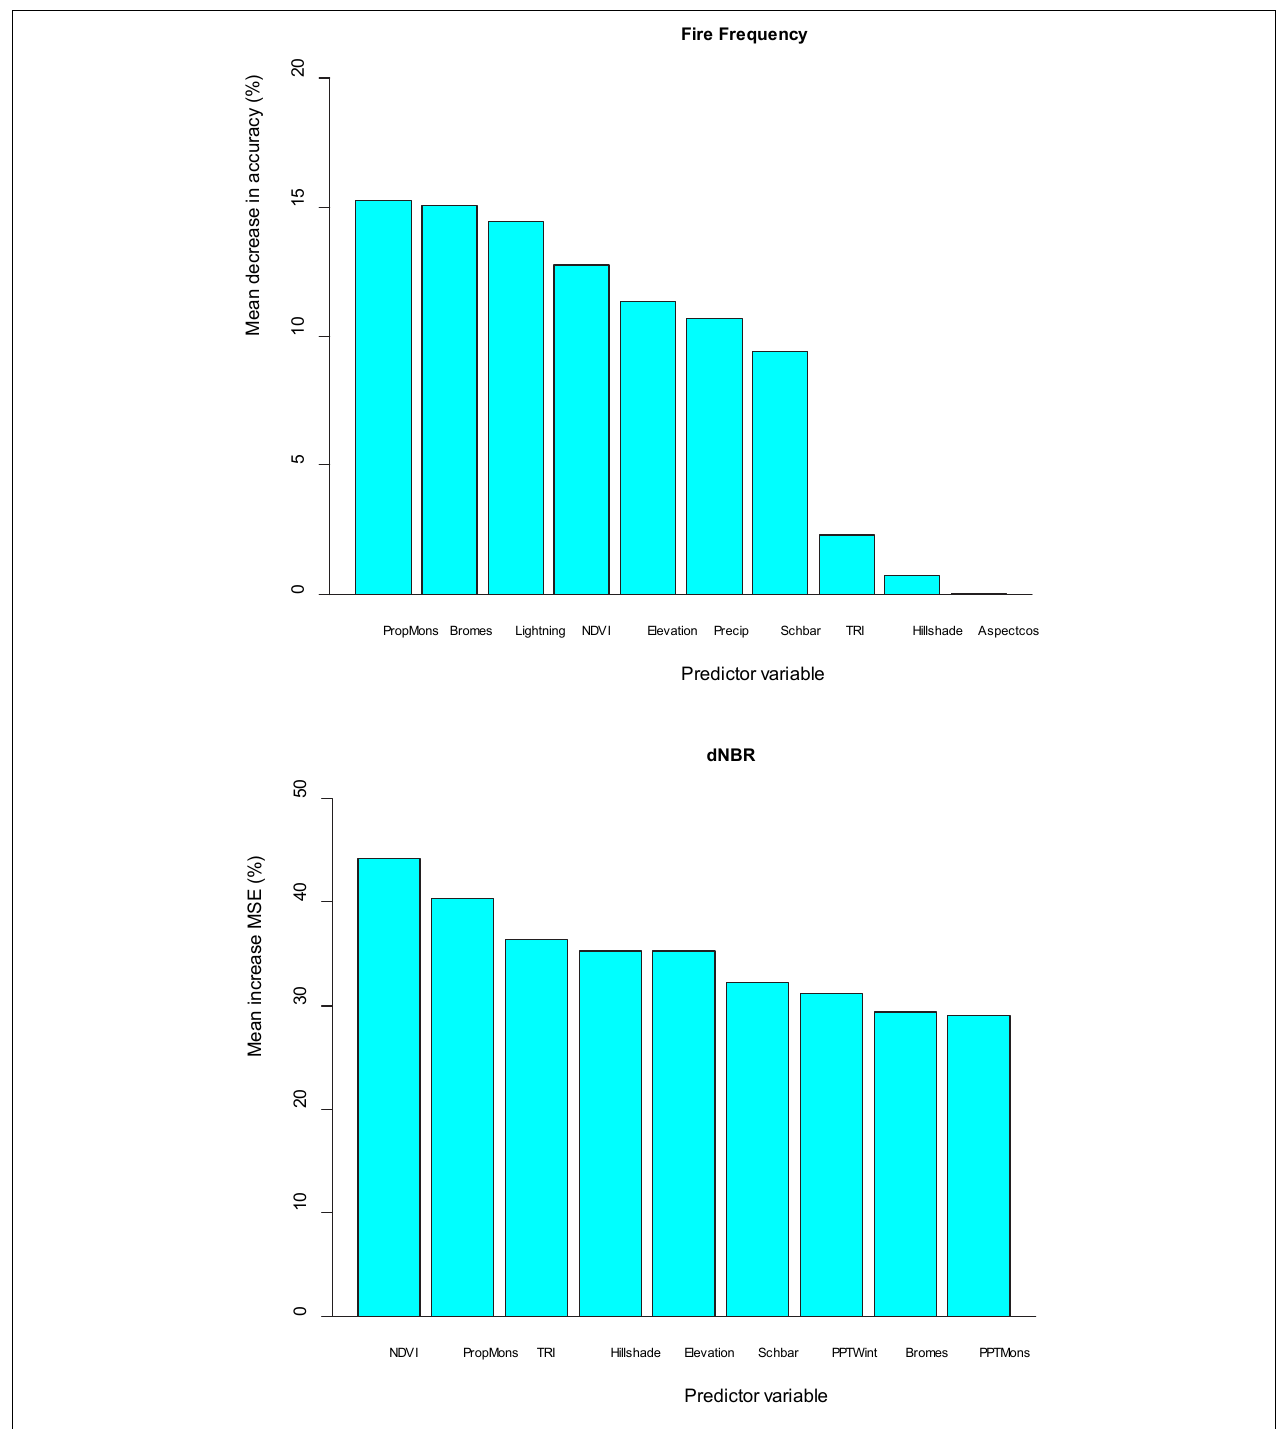
FIGURE 7 | Relative importance values of predictor variables in Random Forest models of fire frequency (number of times burned 1972–2010) and burn severity (dNBR) in the Mojave Desert of North America. Full names and definitions of predictor variables are given in Table 1 .